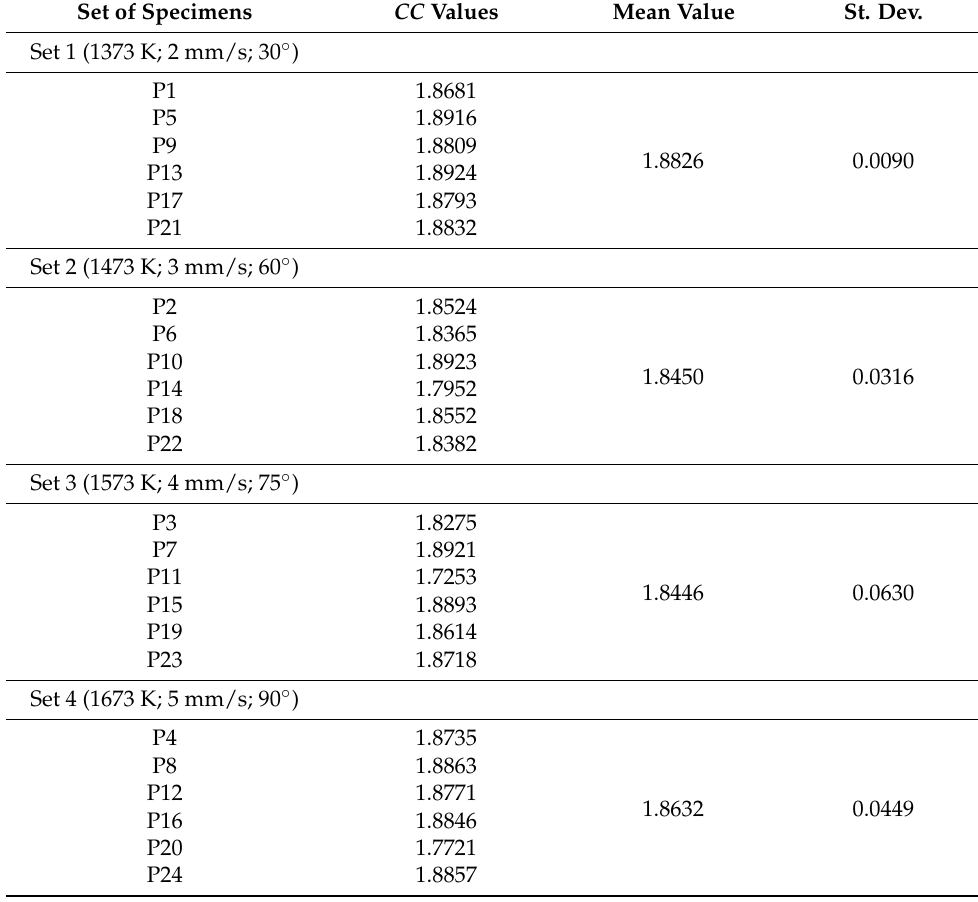
Table 4. Mean values and standard deviation of D parameter. Set of Specimens CC Values Mean Value St.